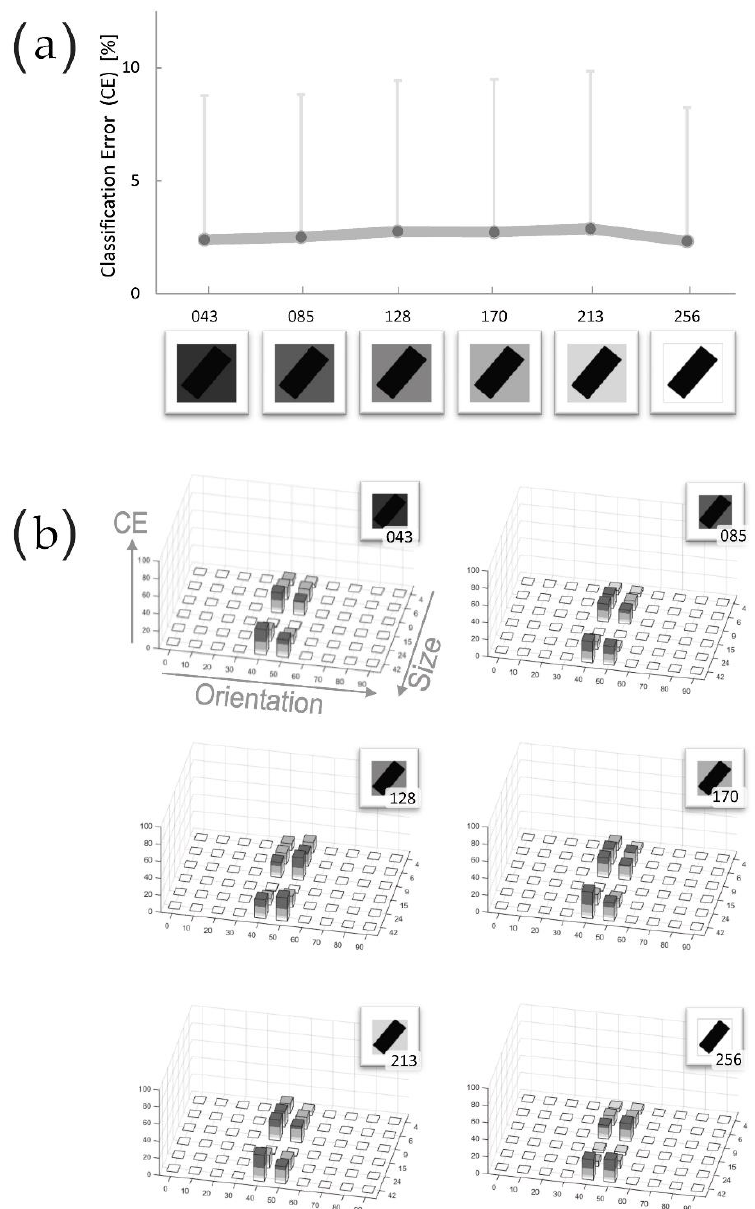
Figure 5. Uniform Bars on uniform Background: manipulation of the Background Luminance. ( a ) Results of tests on black Bars on uniformly filled background; the graph presents the mean values and standard deviations of CE for the six experimental conditions, corresponding to six Luminance values reported in the X-axis. ( b ) Detailed results for each Luminance condition (specified in each superposed image). In each histogram, X and Y axes report respectively the ten orientations and the six sizes characterizing each item, as previously presented in Figure 3.